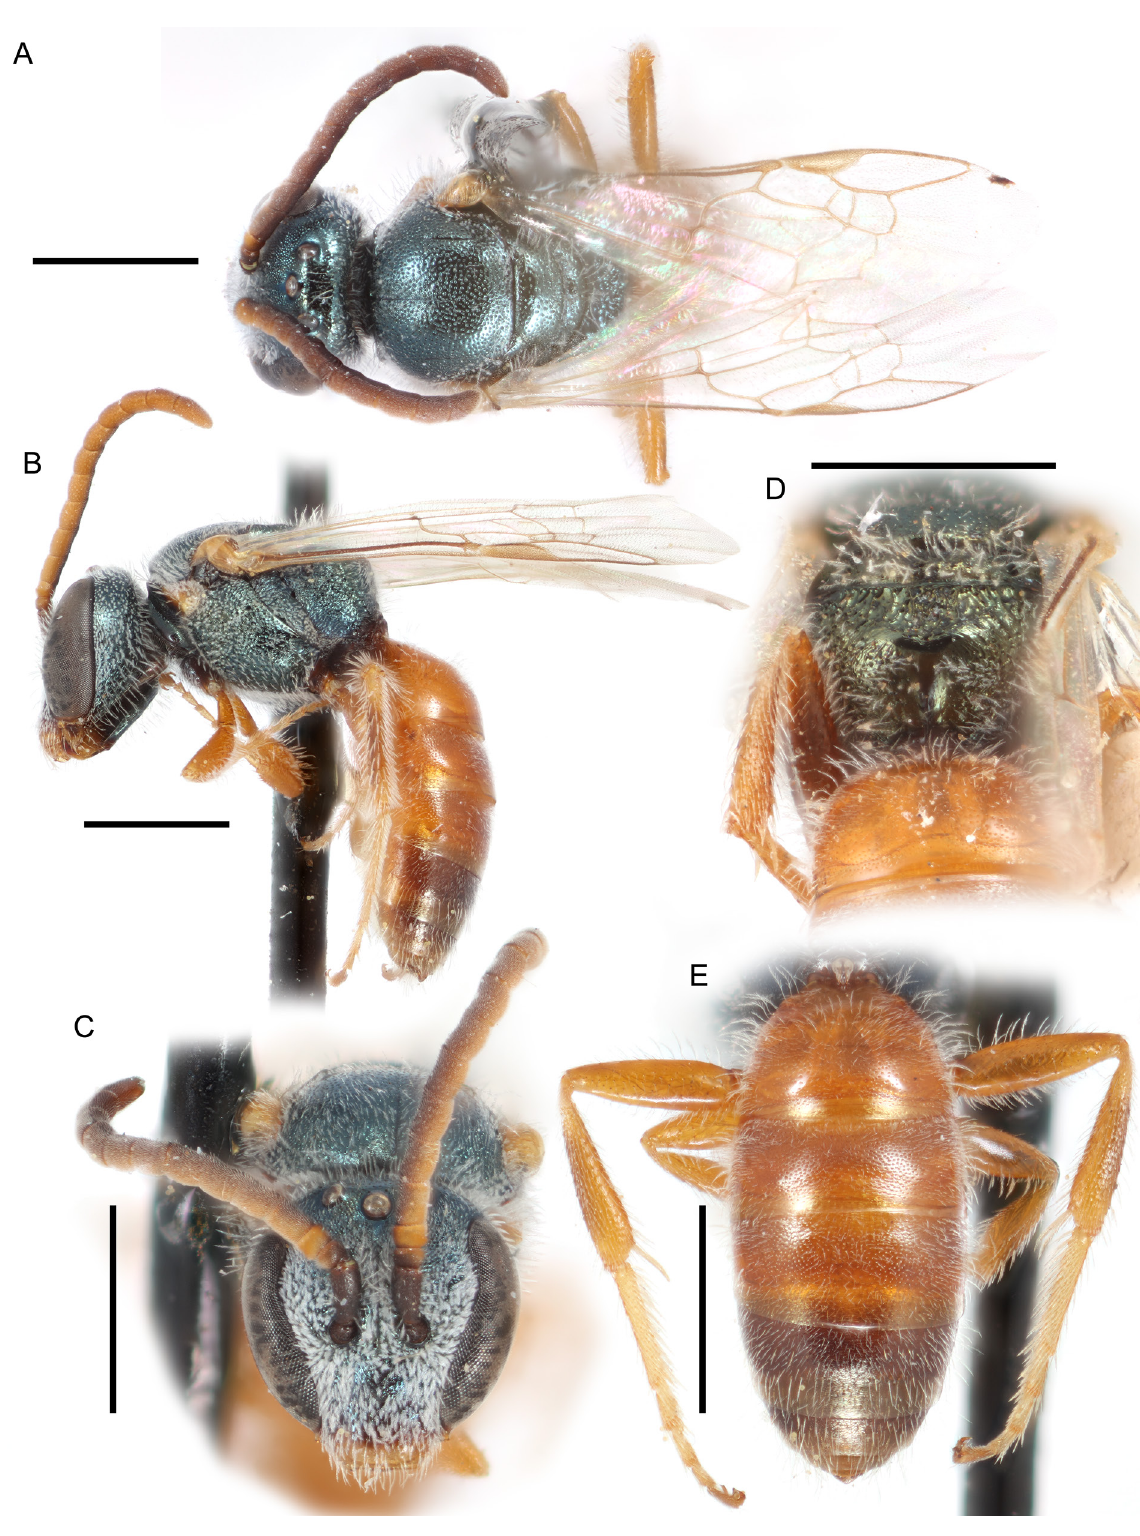
Fig. 9. Lasioglossum ( D. ) arenisaltans sp. nov., ♂. A . Dorsal habitus. B . Lateral habitus. C . Face. D . Propodeum. E . Metasoma. Scale bars: 1